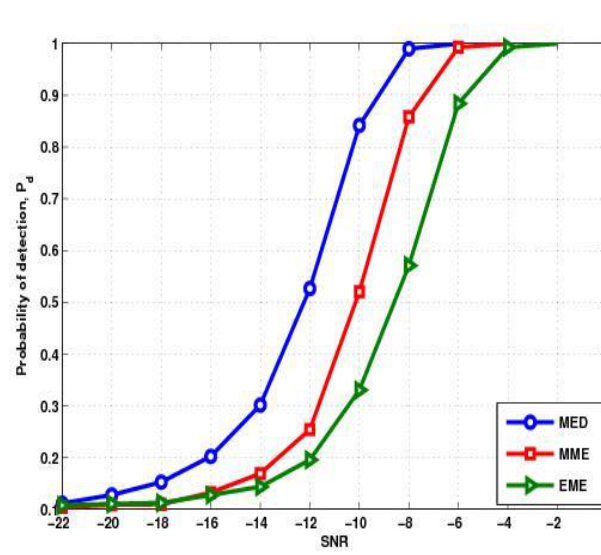
Figure 5. Comparison of probability of detection vs SNR: P fa =0.1, m=4,